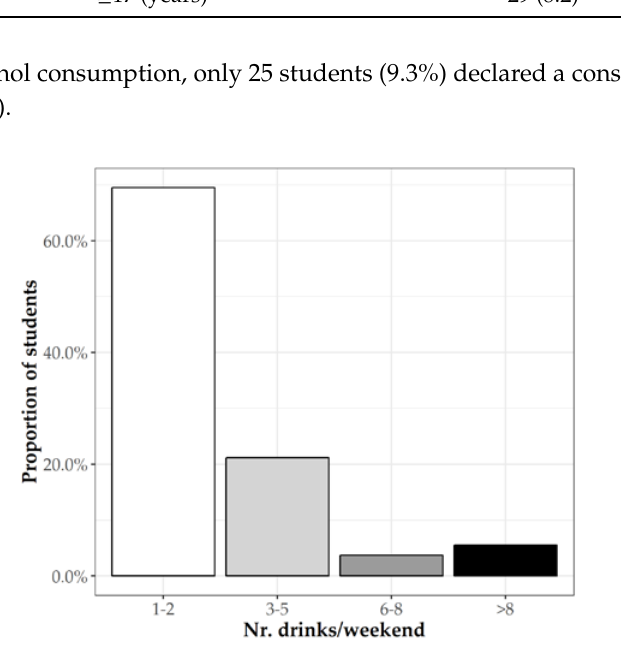
Figure 2. Number of alcoholic drinks/weekend.